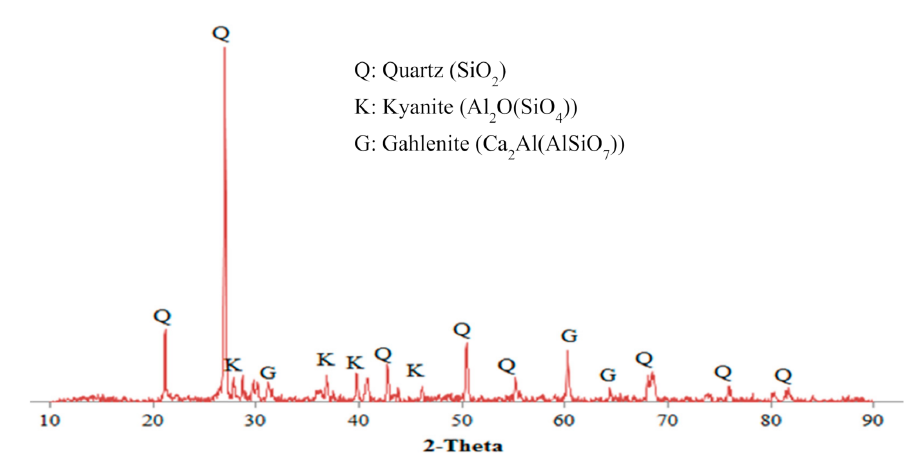
Figure 4. XRD pattern of POFA